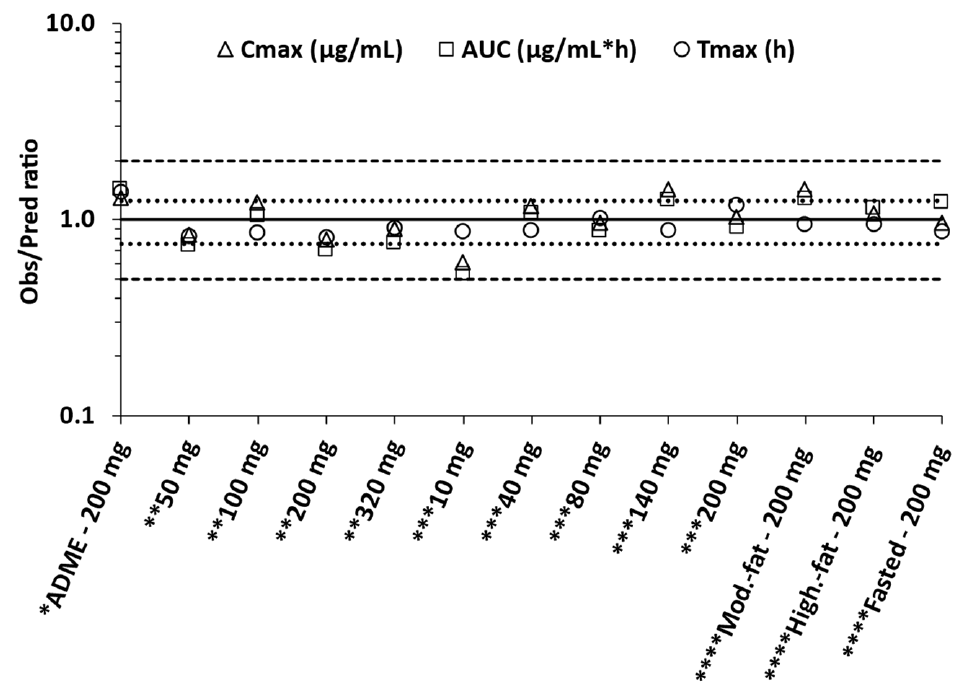
Figure 12. Observed versus predicted ratio of pharmacokinetic parameters of GSK254. The solid line represents the line of unity, dot lines 1.25 and dashed lines the 2-fold error thresholds. * Wen et al. [12], ** Joshi et al. [1], *** Spinner et al. [2], **** Johnson et al. [11].